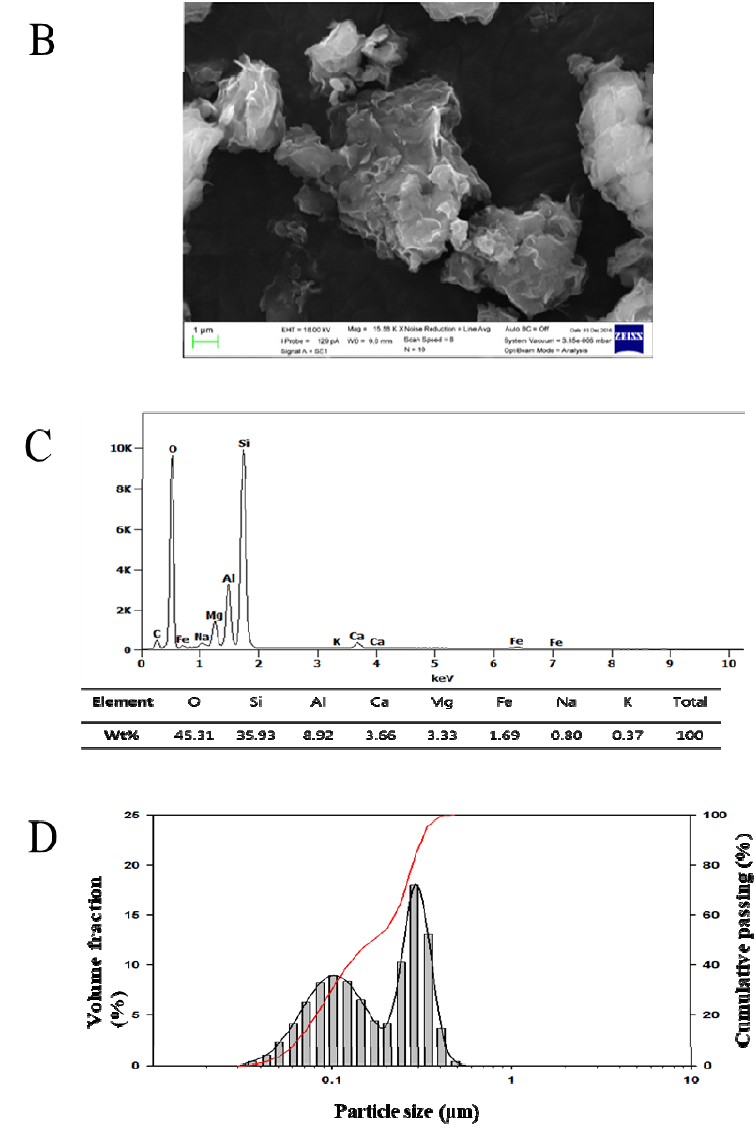
Figure 1. ( A ) X-ray powder diffraction (XRD) pattern, ( B ) scanning electron microscopy (SEM) image (magnified 15.58K-fold), ( C ) energy-dispersive X-ray spectroscopy (EDS) spectrum of purified montmorillonite, and ( D ) particle-size distribution of the nano-montmorillonite